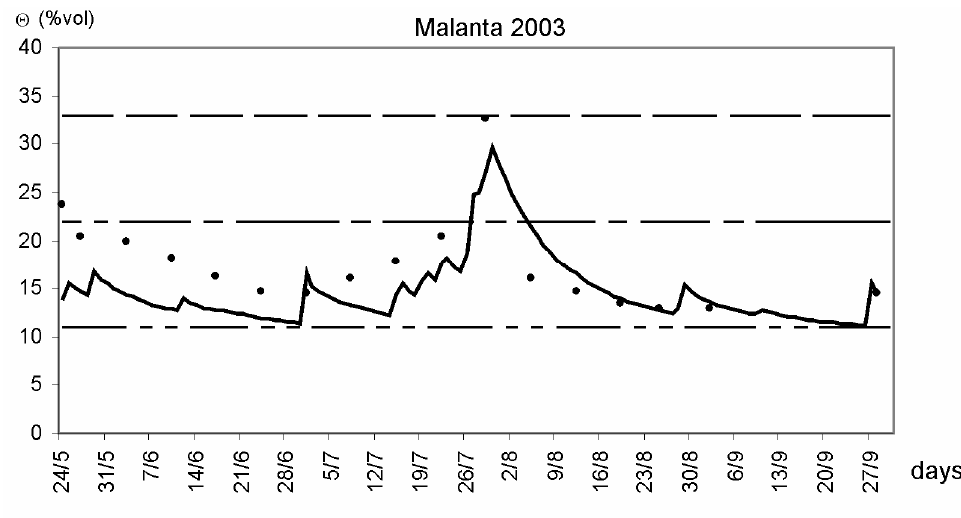
Fig 5. Measured and simulated values of volumetric soil water content in study area of Malanta in 2003